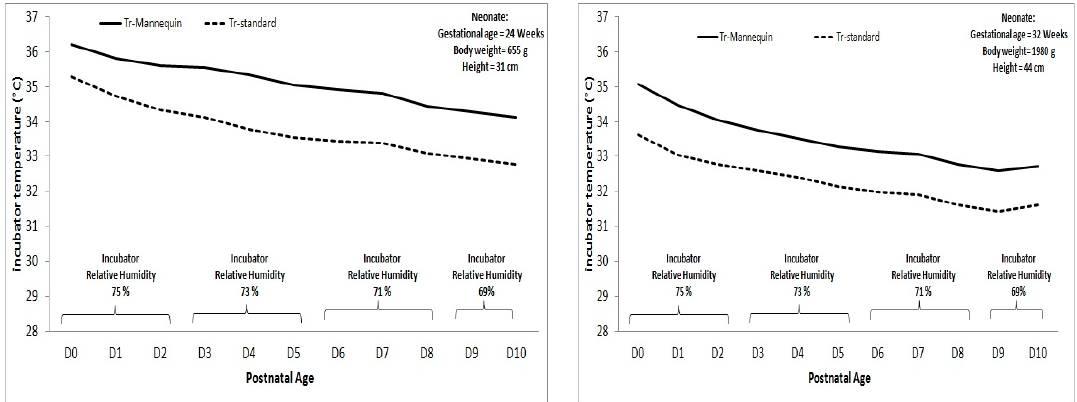
Figure 4. Optimal incubator air temperatures (T inc ) in a mathematical model as a function of postnatal age for two neonates (body mass: 655 g and 1980 g, respectively). T inc was calculated using the mean radiant temperature measured with a standard black-globe thermometer (T r –standard, dotted line) or using a thermal mannequin (T r –mannequin, full line). The relative humidity levels are those commonly recommended by Helder et al., (2008) [29] in the incubator for these populations of neonates.